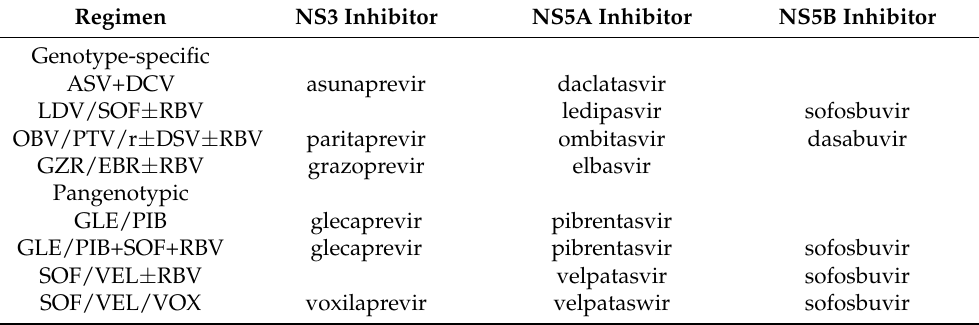
Table 1. Genotype specific and pangenotypic regimens and their